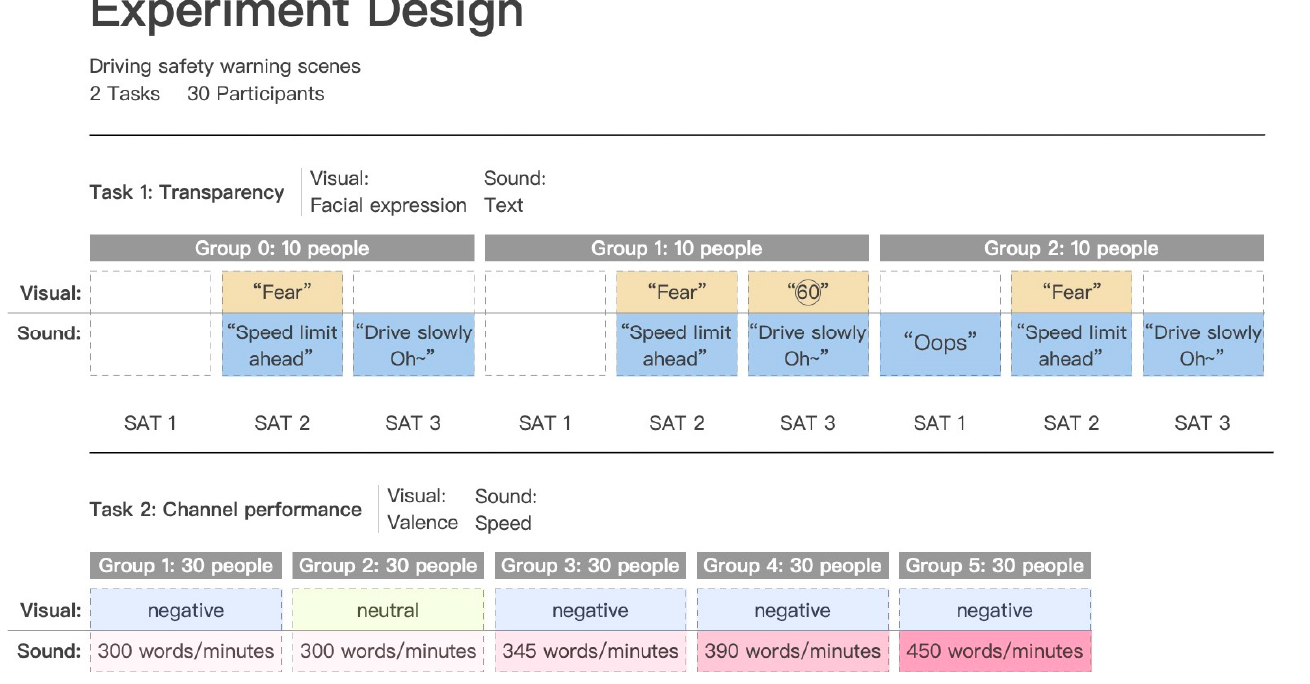
Figure 5. Different transparency modes for task 1; different speech, speed, and facial-expression valence for task